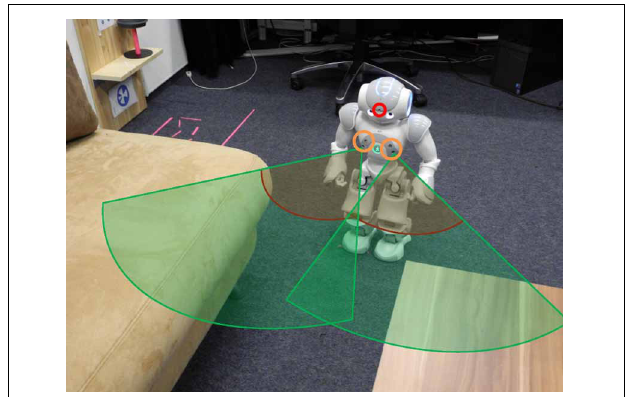
FIGURE 3 | Schema of robot sensors. The robot uses a head camera (red circle) and two pairs of sonar sensors (orange circle on the chest). The detection ranges of the sonar sensors are illustrated via two green pies. Within the dark red line, the robot only knows that an object is present. Here, the robot cannot see the open space in front of